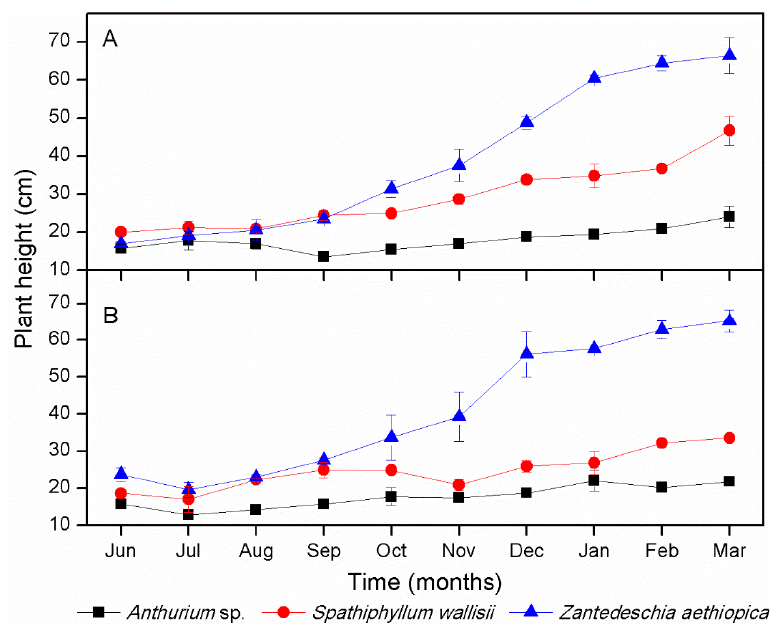
Table 2. Flower production in microcosms. Figure 3. Plant growth of Anthurium sp., Spathiphyllum wallisii , and Zantedeschia aethiopica registered in polyethylene terephthalate (PET) ( A ) and porous river stone (PRS) ( B ) substrates. Values are given as the mean ± standard error.